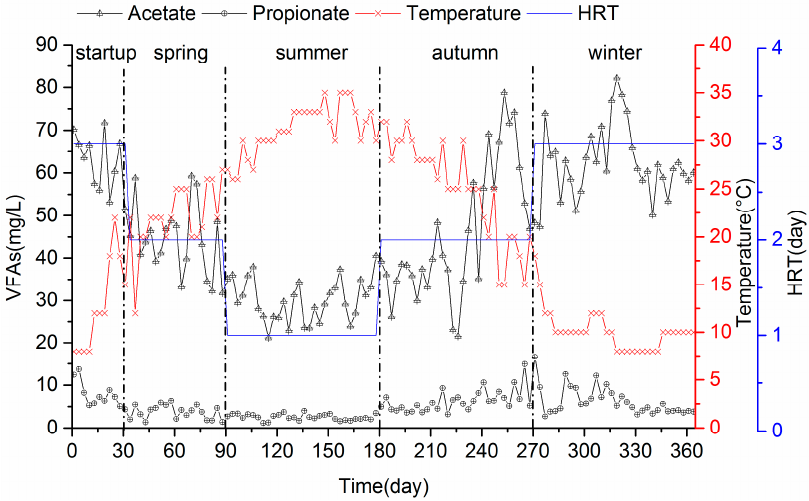
Figure 3. Volatile fatty acids (VFAs) production in the AWFR system during the whole operation.